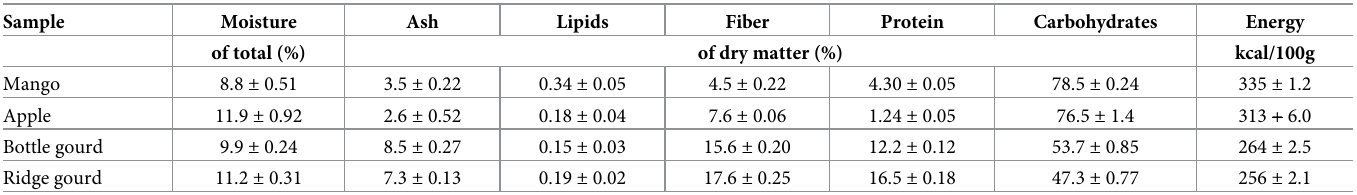
Table 1. Nutritional composition ( ± standard deviation) of fruit and vegetable peels.